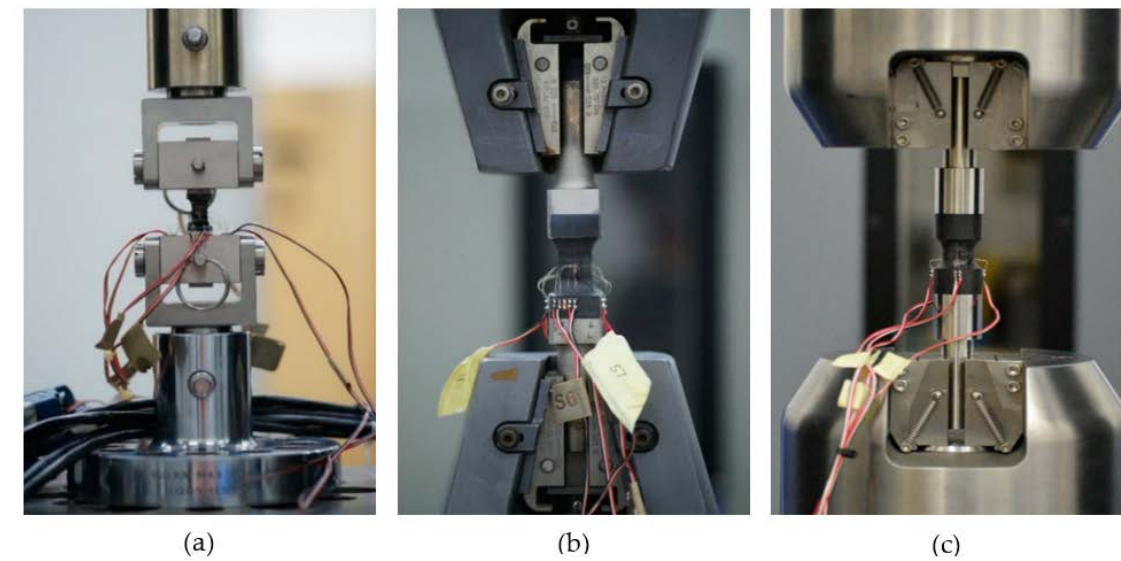
Figure 7. Images of test set-up for ( a ) RARDE Type III (mini) using self-aligning coupling fixture, ( b ) RARDE Type III using manual wedge action grips, and ( c ) ASTM Spool in hydraulic wedge action